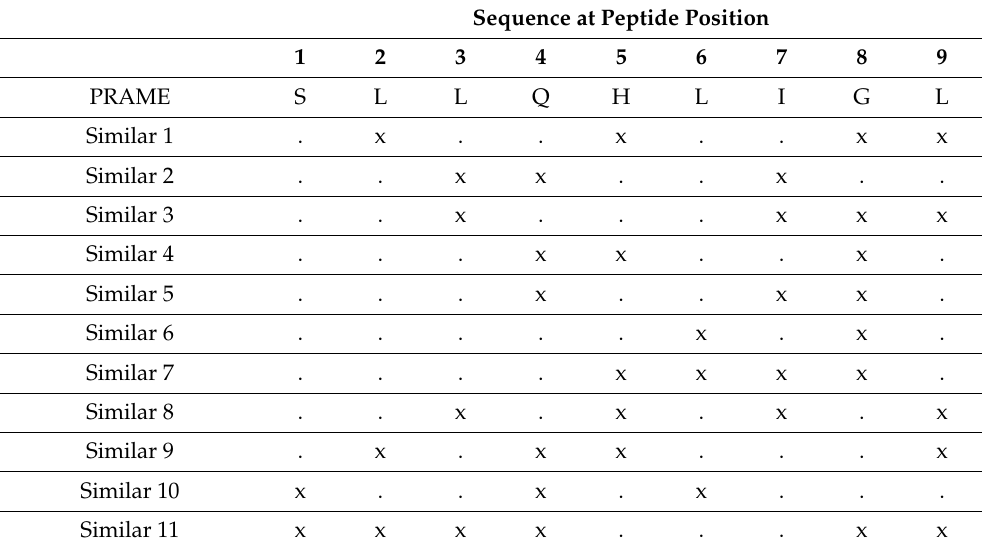
Table 1. Sequence information of similar peptides with “x” representing a variation to the PRAME peptide and “.” representing a wt